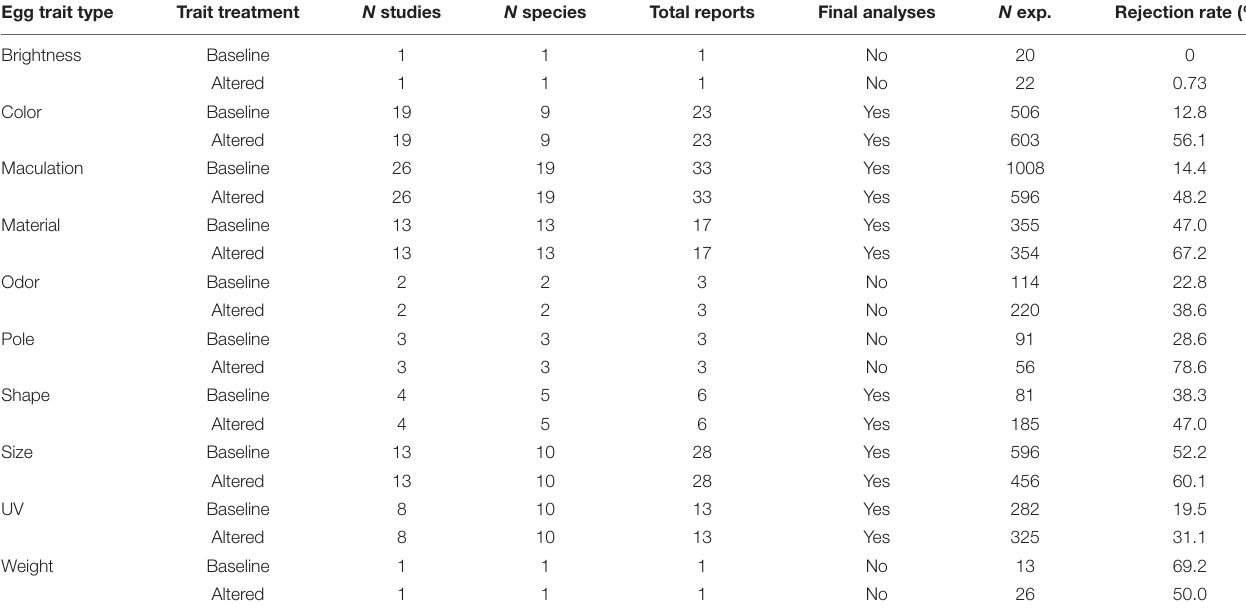
TABLE 1 | Summary of 62 studies on egg trait manipulation to be considered for statistical analyses. Egg trait type Trait